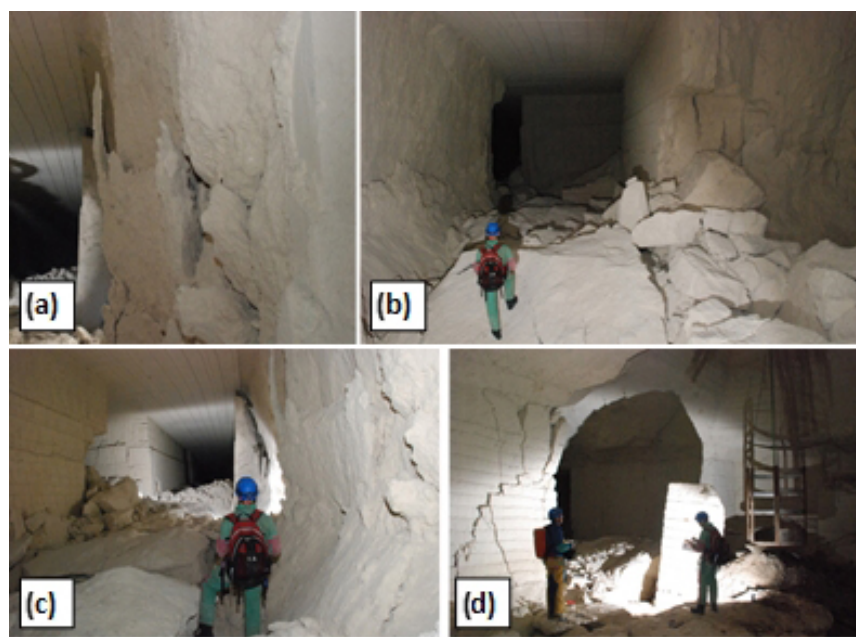
Figure 19. Signs of local instability in the Cutrofiano underground quarries: (a) diffuse fracturing of a wall; (b) detachments of material from walls; (c) massive falls from the walls, with heavy production of debris heaps on the floor; (d) open fractures at the pillar rim, in relation to the main shaft of access to the